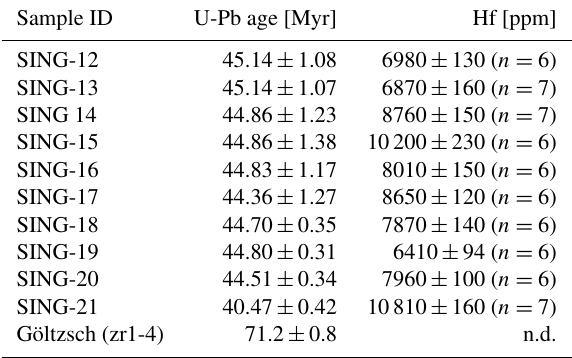
Table 2. Laser ablation ICP-MS age determinations and Hf con- centrations of zircons from Singida, Tanzania (samples “SING”), and Vogtland (“Göltsch (zr1-4)”, mean age of four zircons from the same locality as samples “VOGT” and “GOEL”). The mean age of the samples from Singida is 44.80 ± 0.24Myr (1SD; n = 9; SIN- 21 excluded). Within their individual uncertainties, the individual ages of all zircons, bar SING-21, agree with this mean. The age of SING-21 is significantly ( > 3SD) lower than this mean. The num- bers in brackets denote the number of analyses from which the mean Hf concentration was calculated; n.d.: not